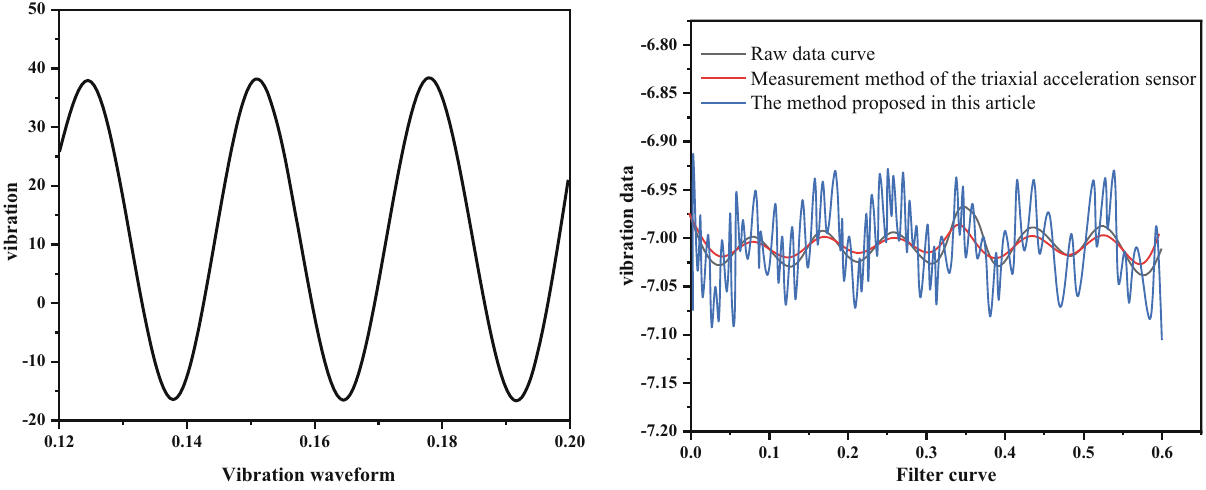
Figure 5: Segmented integral diagram between acceleration peaks. Figure 6: Comparison of 10 Hz and 100 μ m data fi ltering